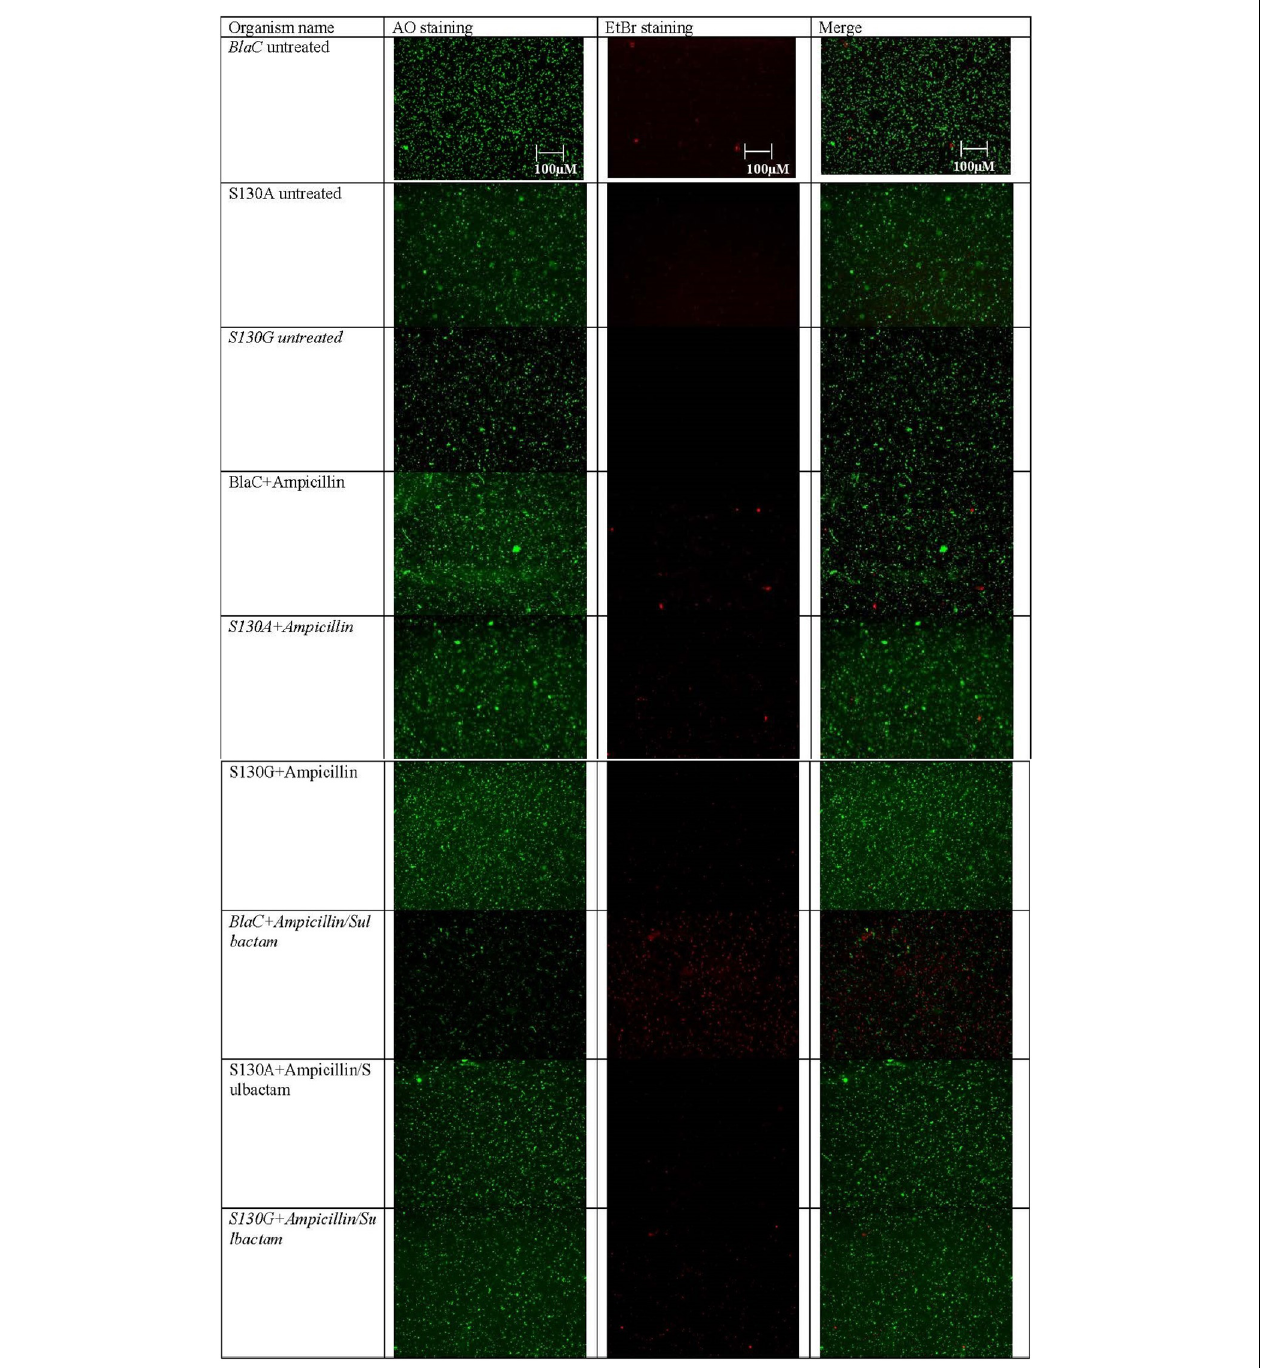
FIGURE 5 | Representative fluorescence microscopy images of AO/EB-based dual staining of clone expressing wild-type BlaC and its two variants S130G and S130A after incubation with ampicillin, sulbactam, and ampicillin/sulbactam to determine the emergence of resistance occurring through particular point mutation.